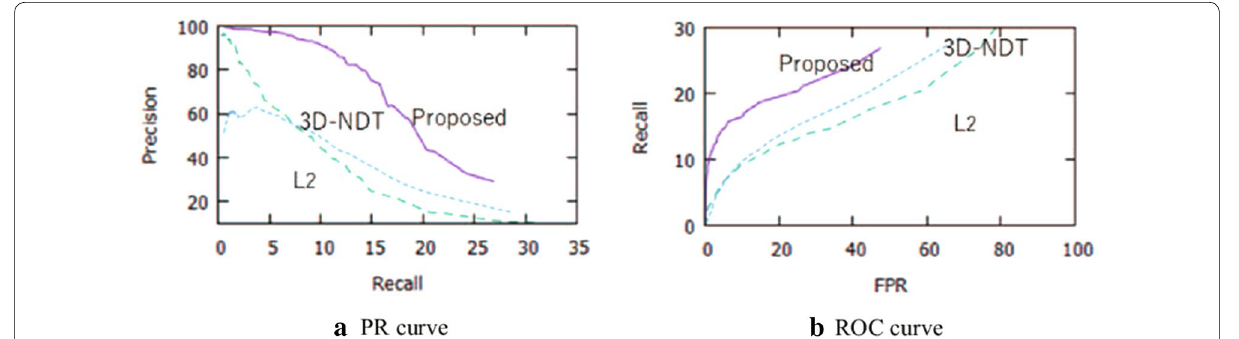
Fig. 19 PR and ROC curves in outdoor